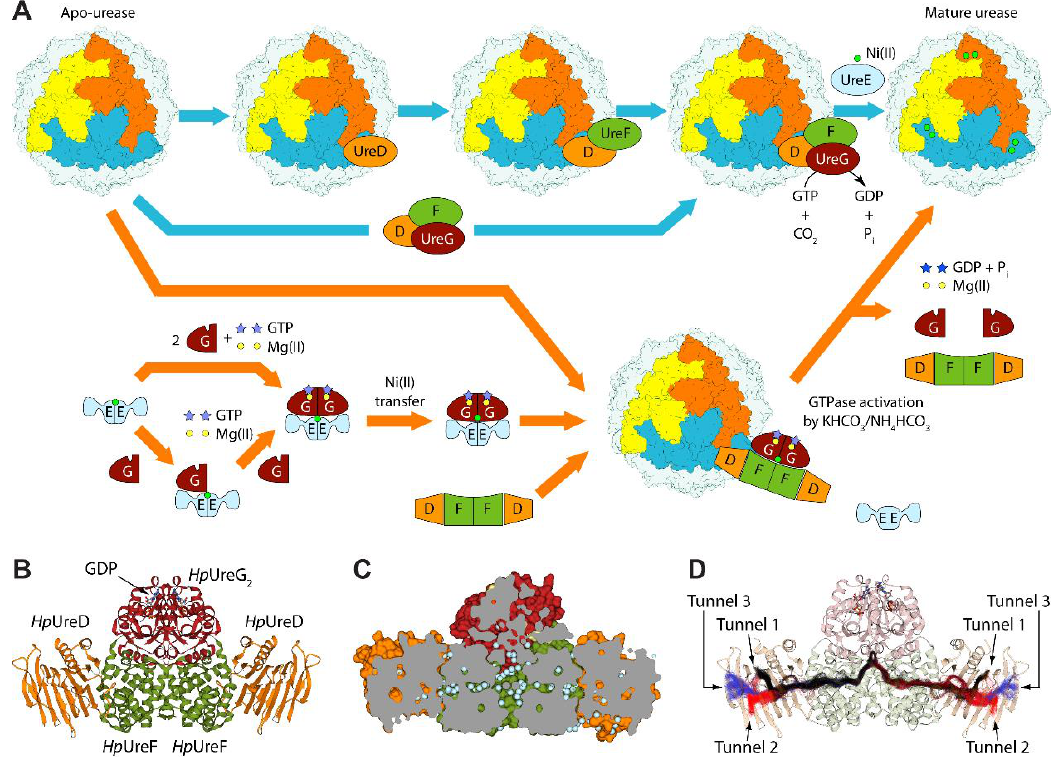
Figure 1. ( A ) Quaternary structure of urease from H. pylori (Protein Data Bank (PDB) id 1E9Z) and schematic representation of the proposed mechanisms for urease activation. The colored chains highlight the trimer that constitutes the minimal quaternary structure of urease, while the other three trimers constituting the active form of the enzyme in H. pylori are in grey. The Ni(II) ions (located at the bottom of the reaction site cavity) are shown as green circles. ( B ) Ribbon diagram and ( C ) longitudinal section of the solvent-excluded surface of the apo Hp UreDFG crystal structure (PDB id 4HI0). Hp UreD, Hp UreF, and Hp UreG chains are colored as in Panel ( A ). Water molecules are depicted as light blue spheres, and GDP is shown as balls-and-sticks and colored according to atom type. ( D ) Ribbon diagram of the Hp UreDFG complex and tunnels identified throughout the molecular dynamics (MD) simulation, all depicted in one frame as the tunnel centerlines. Tunnels 1, 2, and 3 are reported in black, blue, and red, respectively.